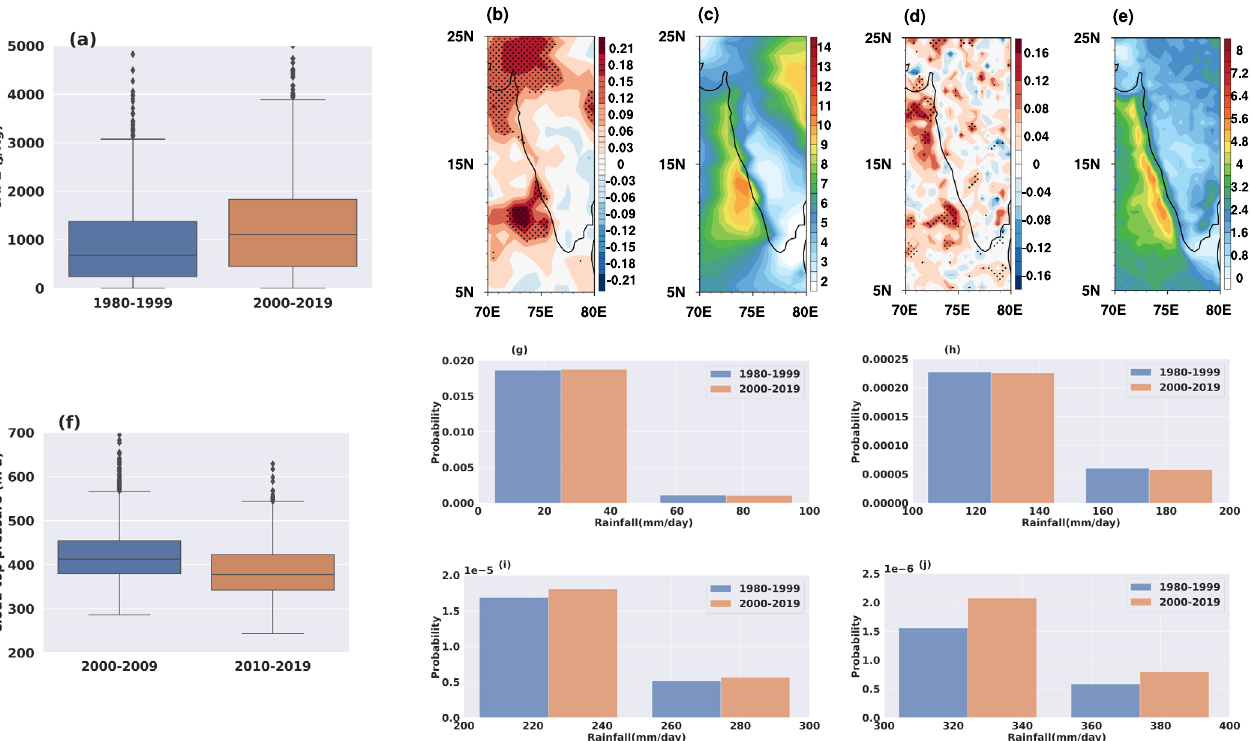
Fig. 5 Trends in CAPE, cloud depth and rainfall from direct observations. a Box plot illustrating changes in CAPE during JJAS over the west coast (12.9 °N and 74.8 °E) from 1980 to 1999 and from 2000 to 2019. In box-part (shaded), the centre line represents the median, bottom and top-line represents the 25th and 75th percentile of data, respectively. The whiskers represent 1.5 times the inner quartile range (IQR), and data outside the 1.5*IQR is identi fi ed as outliers. Direct observations of trends by satellite. b Spatial patterns of the 1998 – 2014 linear trends of the average JJAS deep convective cloud cover from ISCCP-H series data (unit:%.day − 1 .17year − 1 ) with stippling indicates statistically signi fi cant areas at 95% con fi dence level. c Climatology of deep convective cloud cover (unit: %). d Spatial patterns of the 1998 – 2014 linear trends of the average JJAS convective rainfall from TRMM (unit: mm.day − 1 .17year − 1 ) with stippling indicates statistically signi fi cant areas at 95% con fi dence level. e Climatology of convective rainfall (unit: mm.day − 1 ). f Box plot illustrating the monthly averaged CERES-MODIS cloud top pressure changes during JJAS over the west coast from 2000 to 2009 and from 2010 to 2019. In box-part (shaded), the centre line represents the median, bottom and top-line represents the 25th and 75th percentile of data, respectively. The whiskers represent 1.5 times the inner quartile range (IQR), and data outside the 1.5*IQR is identi fi ed as outliers. g – j PDF of JJAS rainfall (50 mm.day − 1 bins between 0 and 400 mm.day − 1 ) prepared with the aid of gridded rainfall data from